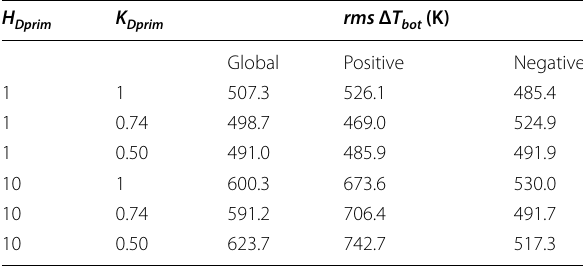
) of the models bot